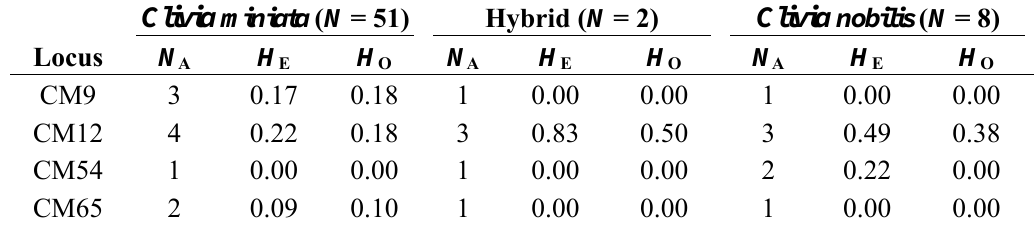
Table 1. Results of initial primer screening in Clivia miniata , Clivia nobilis and hybrids of the two species. Parameters shown for each pair of primers are the number of the